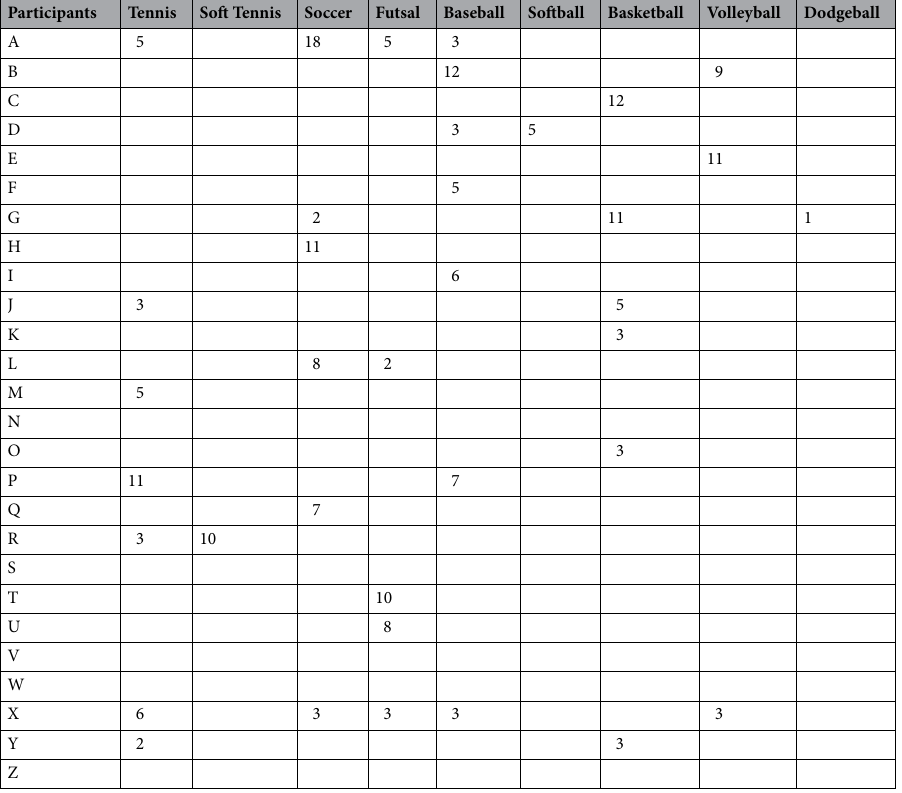
Table 2. Experiences (sports event and years) in ball sports. Each number shows the total years of experience in each sport.